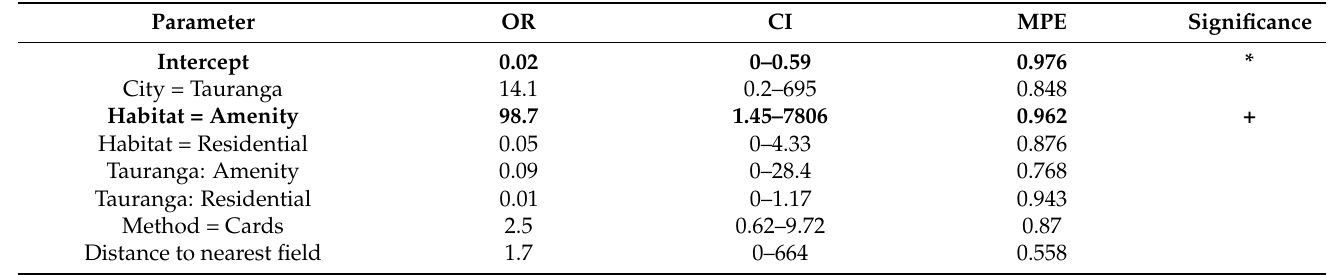
Table 8. Mice: summary statistics for coefficients of the parameters in the two-city mouse model fitted to data from New Plymouth and Tauranga.